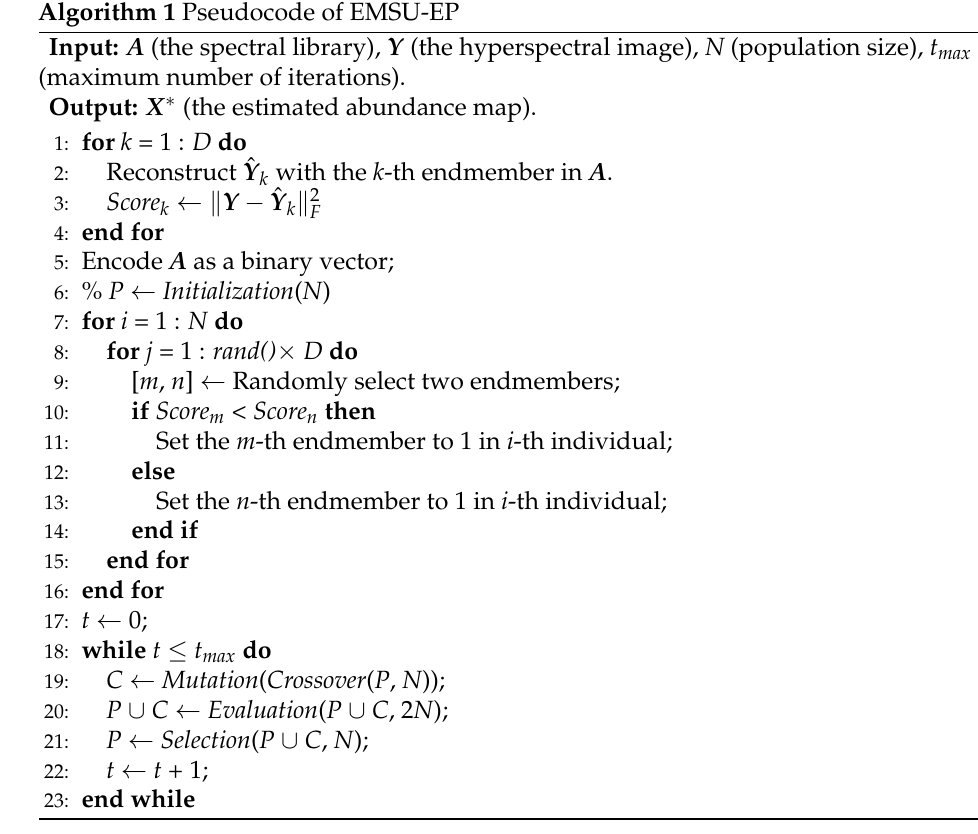
Algorithm 1 Pseudocode of